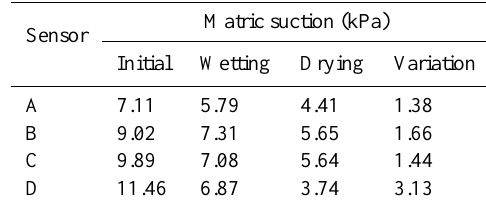
Table 4. Variation of matrix suction in the model slope of 50 ◦ incli- nation.